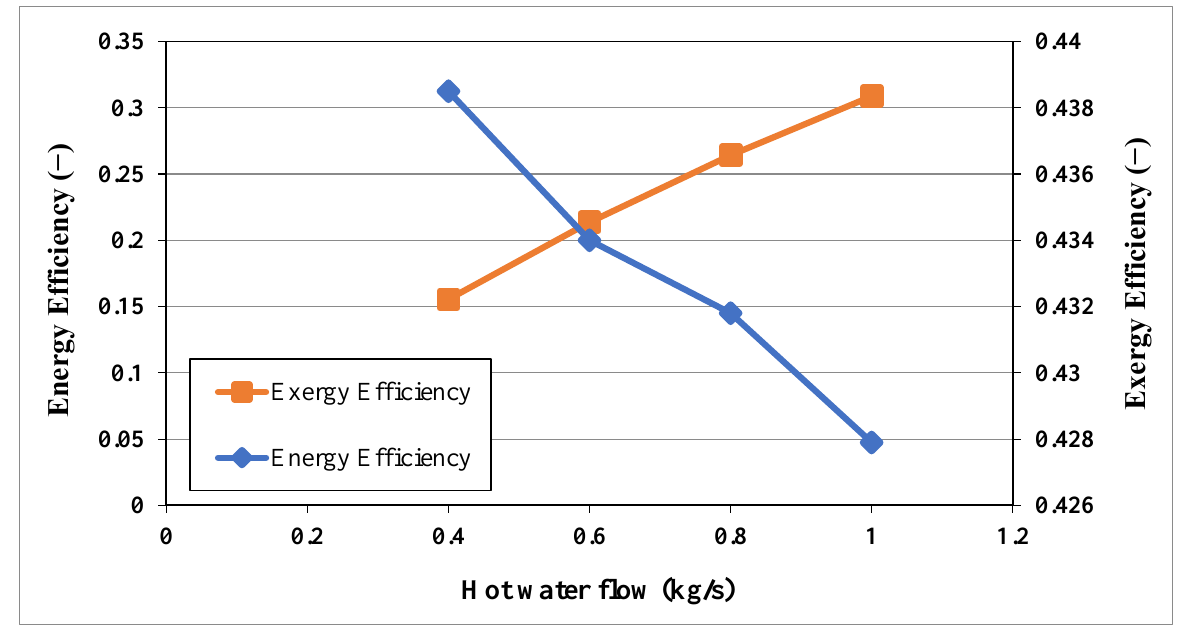
panels was increased. A rise in the warm water flow rate from 0.4 to 1 kg/s increased the rise of the warm water flow rate. This is depicted in Figure 8.